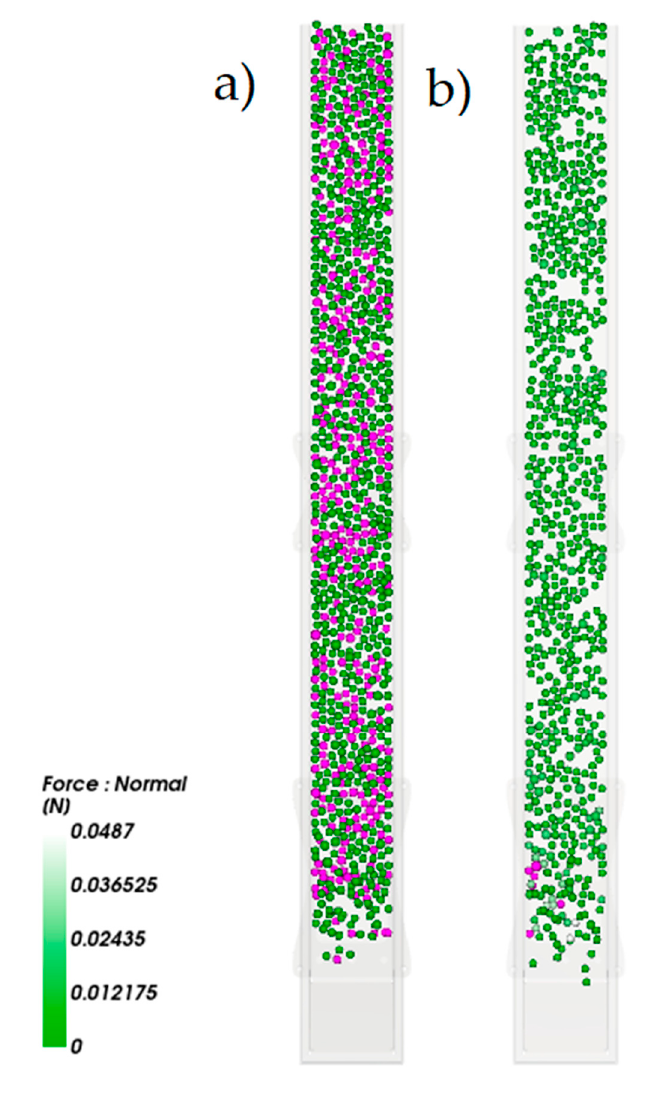
Figure 16. The comparison of the action of normal forces on blueberry fruit during transport on the reciprocating chute ( a ) and on the vibrating chute ( b ). The blueberry with an exceeded value of normal force is marked with a violet color.